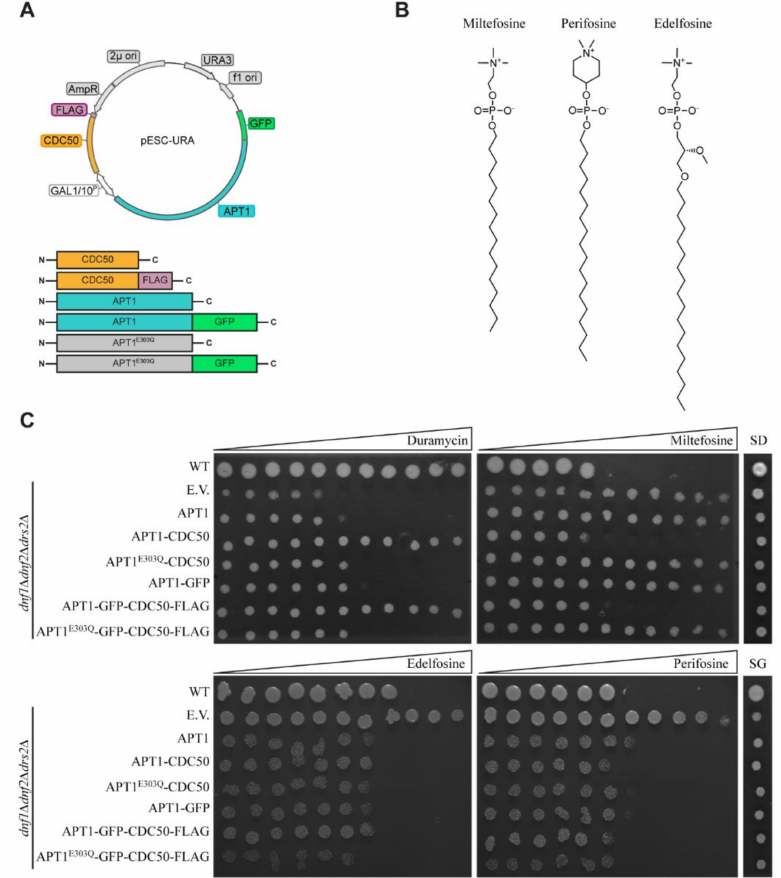
Figure 3. Apt1p/Cdc50p complements the phenotypes of the P4-ATPase-deficient S. cerevisiae strain ZHY709. ( A ) A schematic representation of the episomal pESC vectors used to express APT1 with and without CDC50 under the control of galactose-induced promoters. ( B ) Chemical structures of edelfosine, miltefosine, and perifosine. ( C ) Functional complementation of a P4-ATPase-deficient yeast strain (ZHY709) bearing wild-type Apt1p and mutant Apt1p E303Q in combination with Cdc50p. Yeast strain BY4741 (wild type) and ZHY709 transformed with empty plasmids (E.V.) were used as a positive and a negative control, respectively. Yeast strains were grown at 30 ◦ C on plates containing a concentration gradient of the indicated toxins (the direction of the gradient is indicated by a triangle) or on control plates with glucose (SD, control) or galactose (SG, induced gene expression) with no further additions. The experiment was repeated at least three times with identical